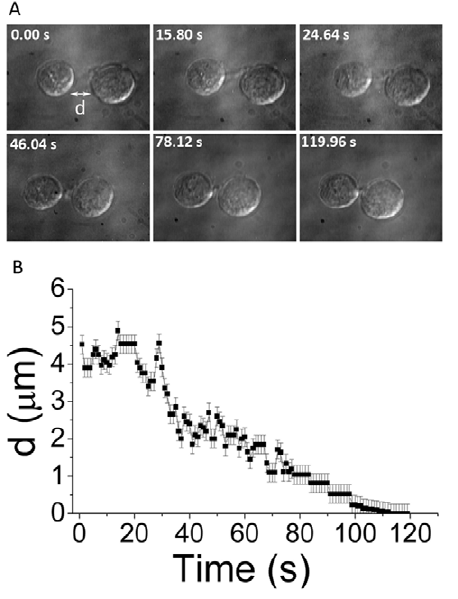
Figure 11. Temporal events post filopodia-mediated adhesion of two neural progenitors. A) depicts time lapse images from a real time movie and B) shows a graphic quantitation. ’d’ is the minimum distance between the surfaces of the two neural progenitors. The scale bar denotes 10 m m.